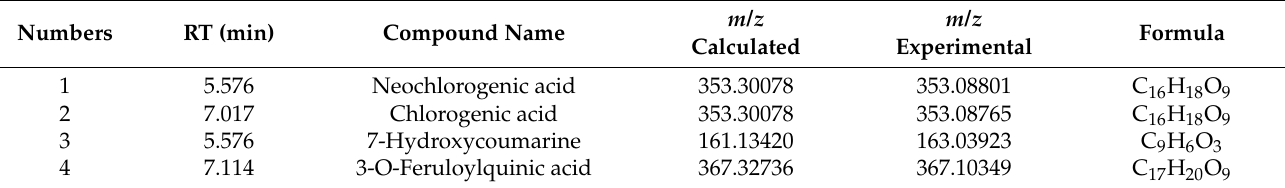
Table 2. Key Phenolic Compounds Found in the Fermentation Waste